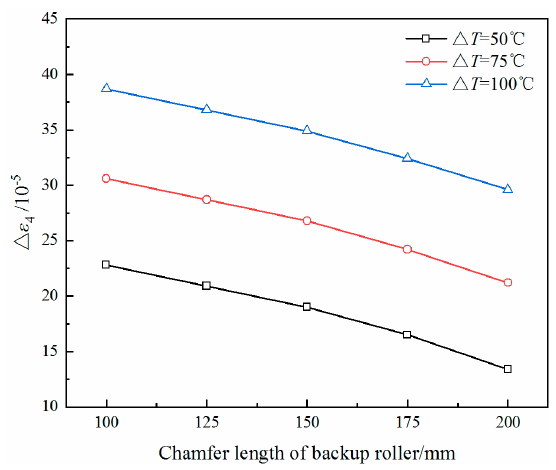
Figure 20. The value of Δ ε 4 of the strip with different chamfer lengths of back ‐ up roll. Metals 2020 , 10 , x FOR PEER REVIEW 18 of 22